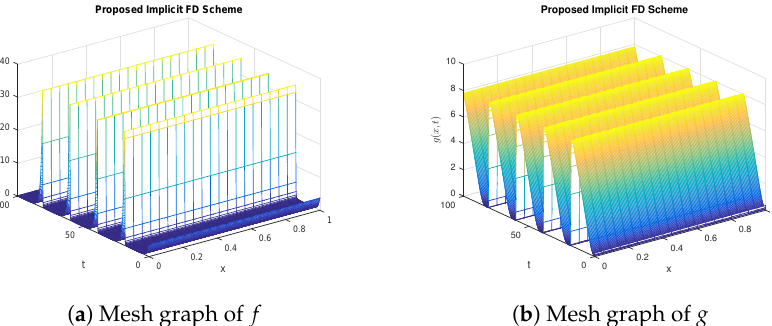
Figure 7. Graphical solution of f , g (concentration of substances) using designed NSFD implicit method at a = 0.008, b = 0.6, χ 1 = 2, χ 2 = χ ∗